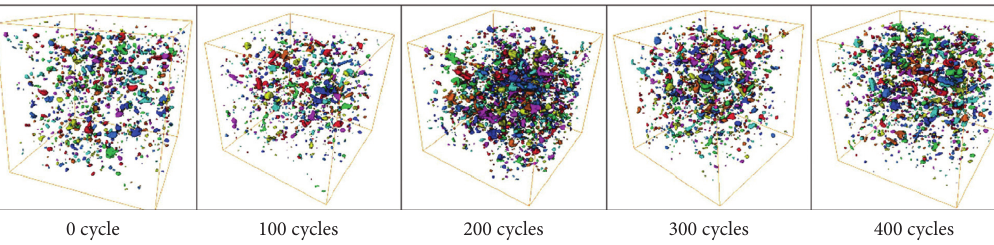
Figure 16: Cube-pore image of 8% CaO expansive concrete (C-8) under different freeze-thaw cycles.